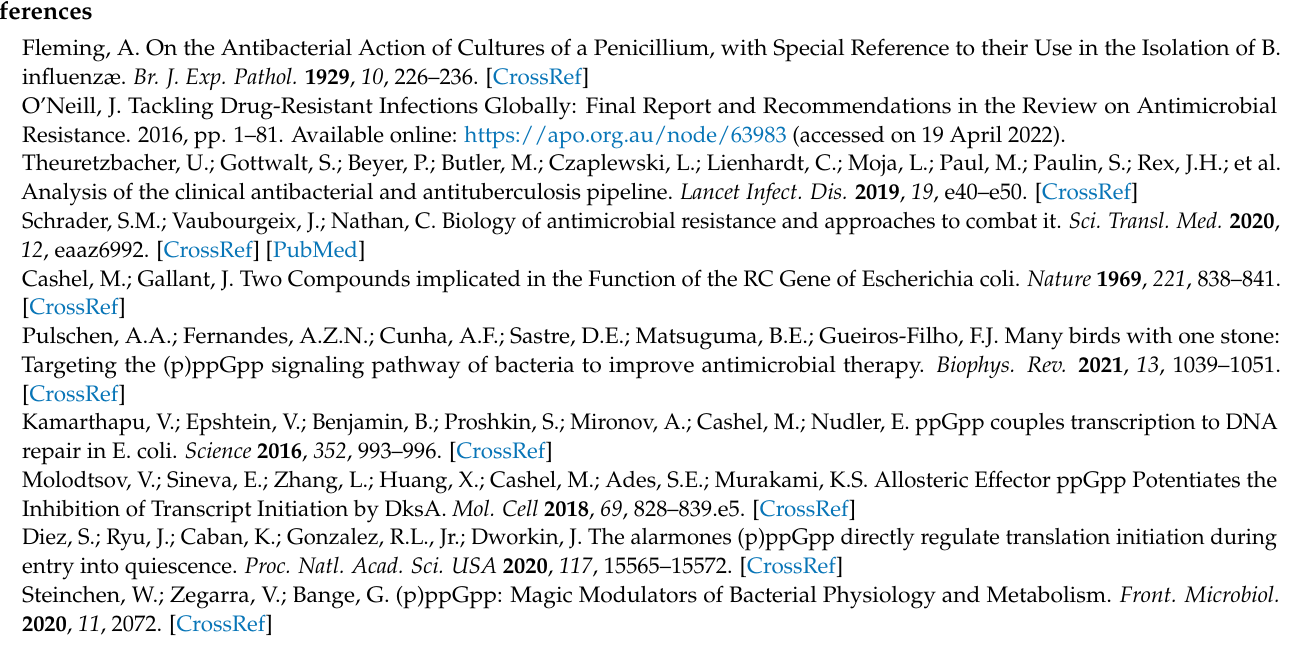
simulations. Figure S5: STD-NMR of B1 with Rel Seq (1–385), Figure S6: STD-NMR of A2 with Rel Seq (1–385), Table S1: Databases used for the virtual screening campaign, Table S2: 3D Datasets used in the VS workflow and enrichment factors calculated for each chemotype, Table S3: Fragment datasets obtained by using PubChem database, Table S4: Docking results for the fragment sets into HIP312 and HIS312